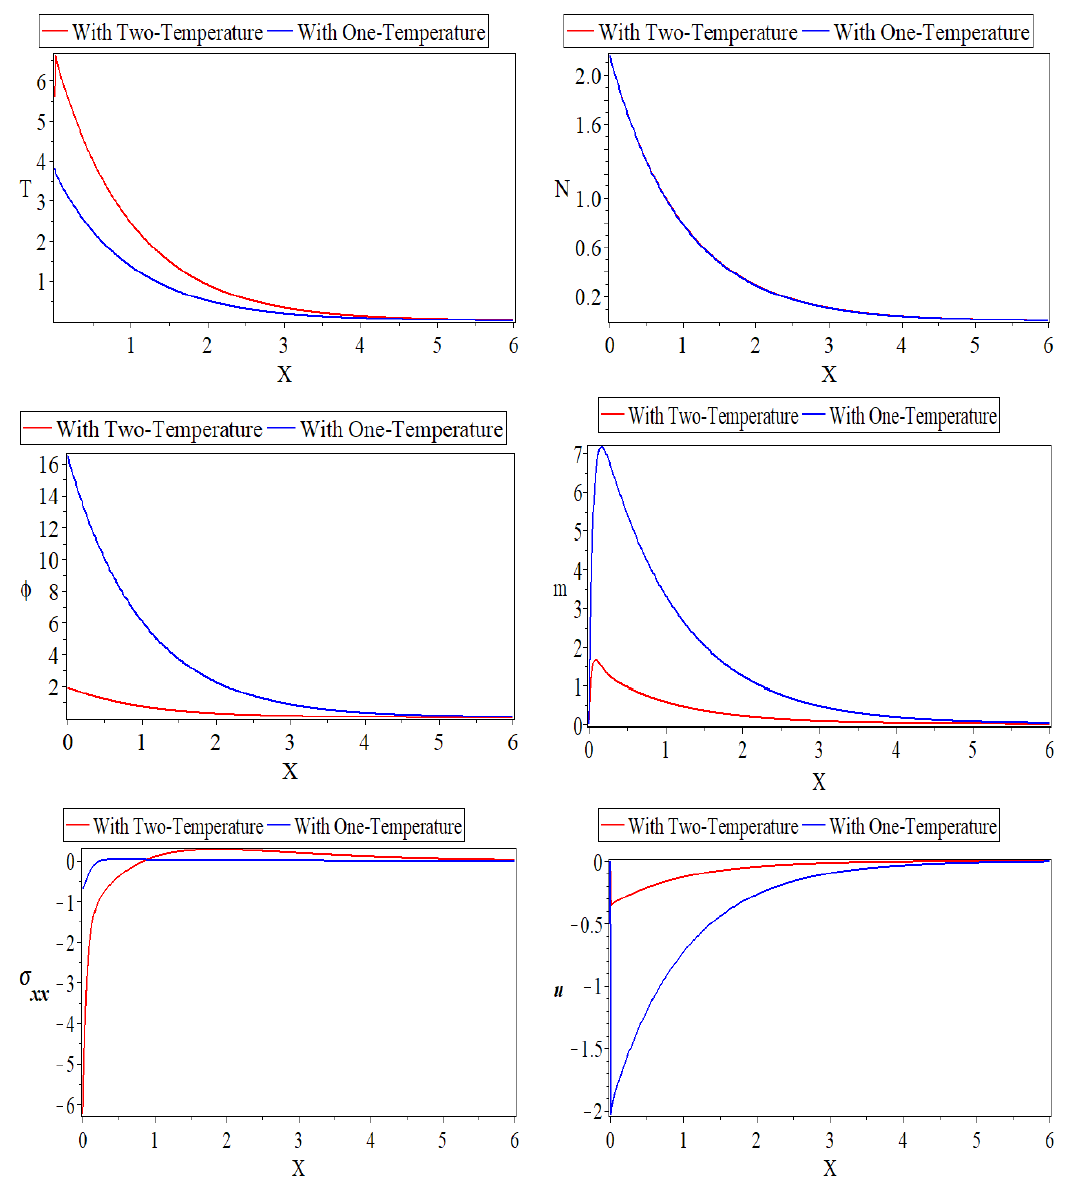
Figure 1. Represents the variations of main fields in this phenomenon according to the different values of two-temperature parameter under the effect of moisture field.